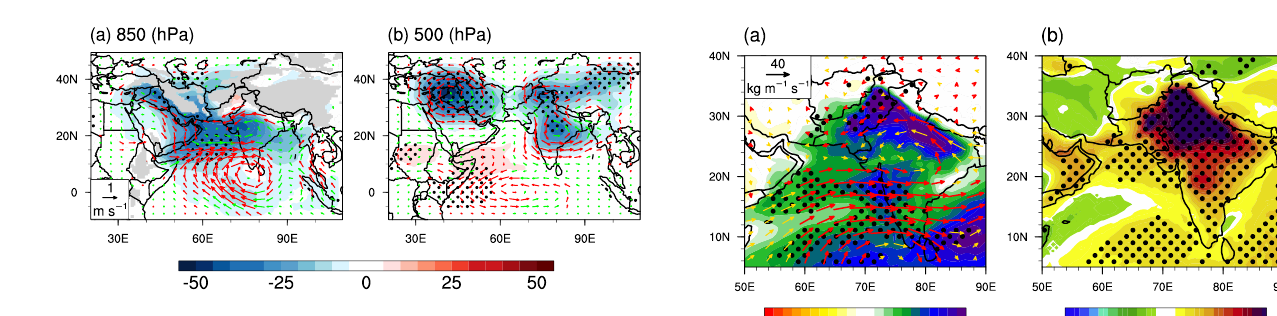
Figure 16. Spatial patterns of WRF-Chem ensemble mean differ- ences in GPH (shading; unit: m) and winds (arrows; units: ms − 1 ) at (a) 850hPa and (b) 500hPa between ALLF and NDST experi- ments. The dotted areas show a 95% confidence level based on a one-sided Student’s t test. The red arrows show wind differences that have a 95% confidence level based on a one-sided Student’s t test, and green arrows are other wind differences (no confidence).